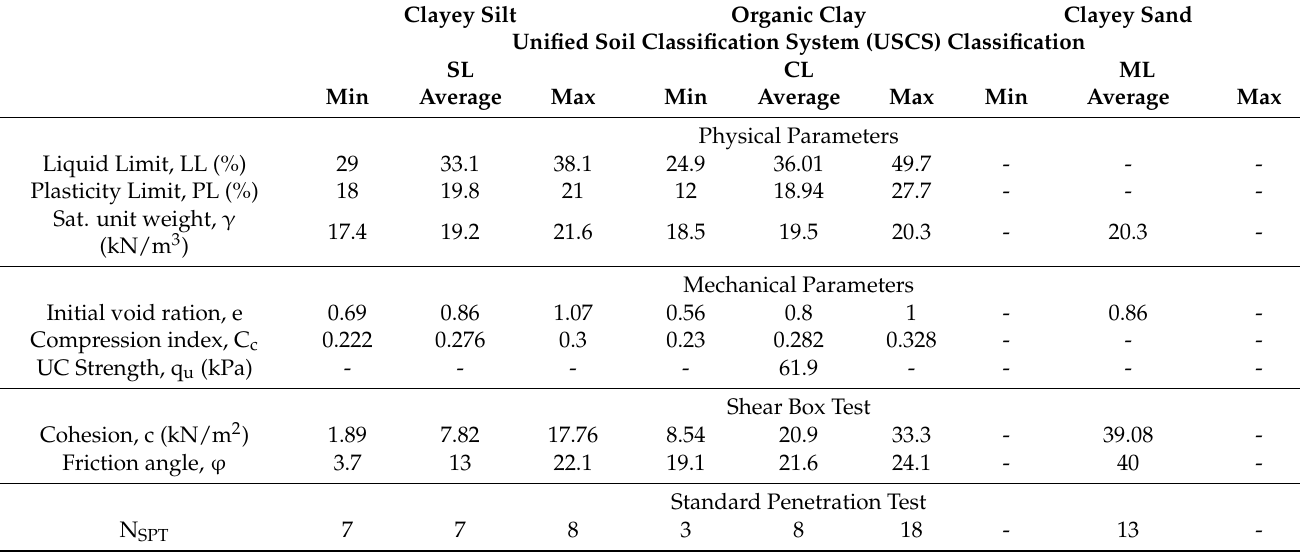
Table 1. Physical and mechanical properties of Clayey Silt, Clay and Clayey Sand foundation formations of